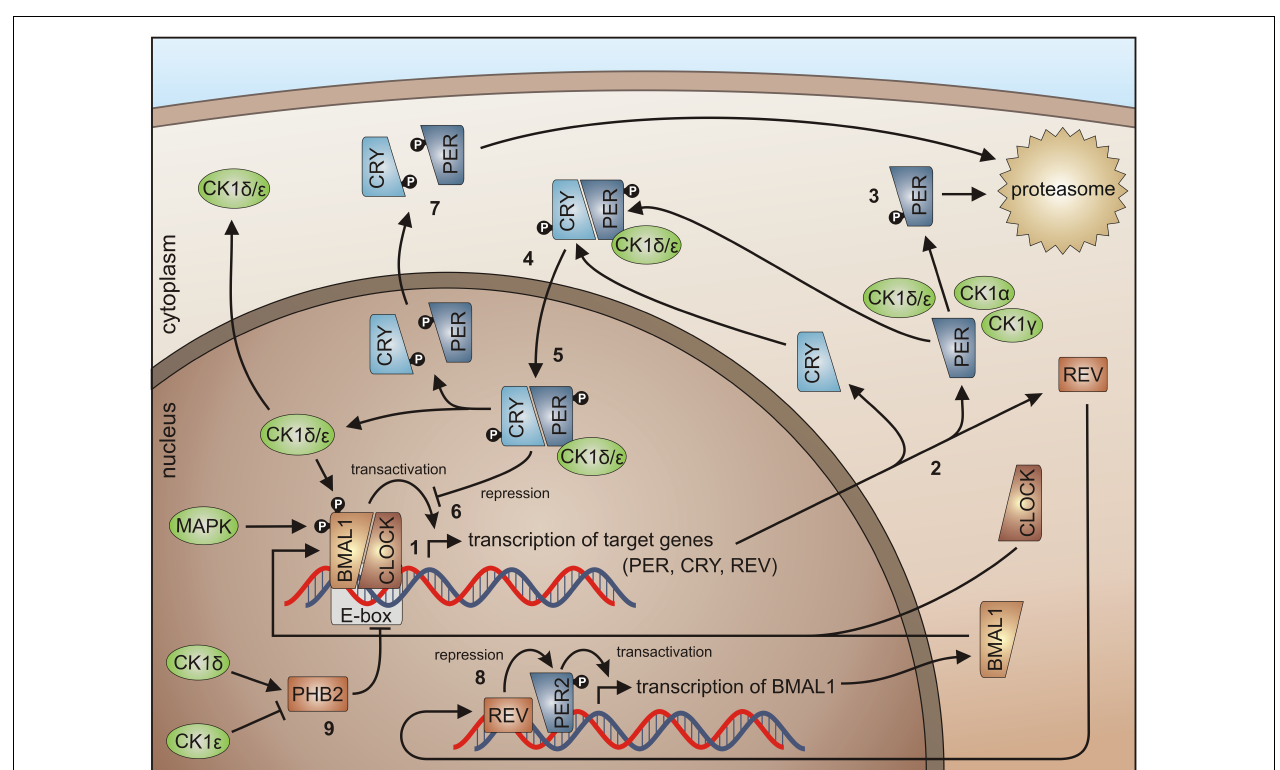
BMAL1/CLOCK target genes (6). CRYs and PERs finally shuttle back to the cytoplasm for proteasomal degradation (7). Repression of BMAL1 expression by REV-ERB α represents a second negative feedback loop (8).Together, these feedback loops are able to generate cyclic expression of BMAL1 and E-box-containing genes [for review see Knippschild et al. (219) and Cheong andVirshup (195)]. CK1 δ and ε differentially effect expression of the period length modulator PHB2.Whereas CK1 δ is able to promote PHB2 transcription, its expression is reduced by CK1 ε (9) (8,